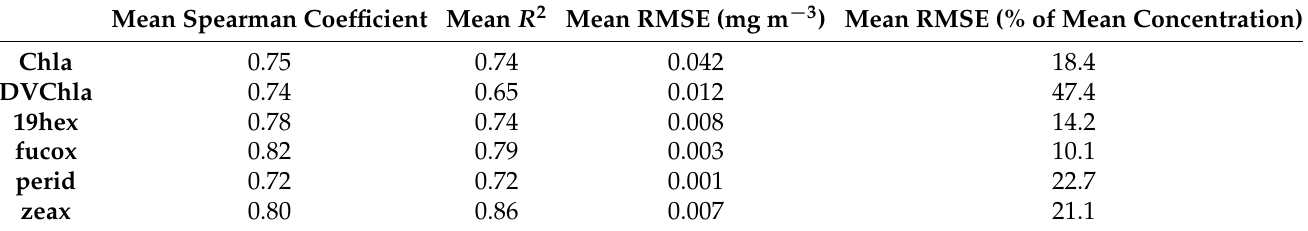
Table 5. Results of the inversion of the Tara test set using the method with PCA preprocessing (two